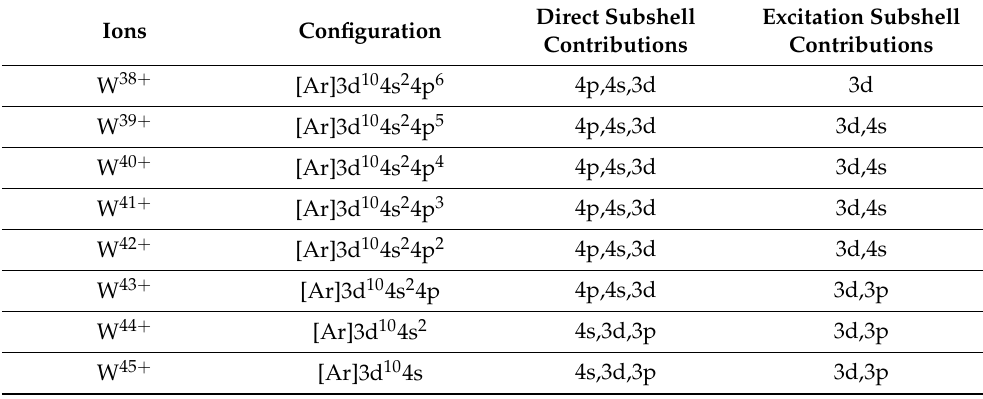
Table 1. Ground-state configurations for W ions and ionization contributions by